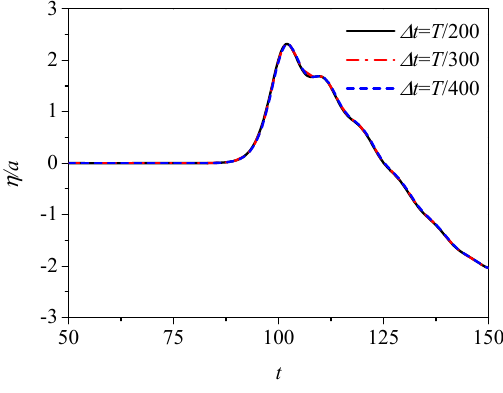
Figure 2. Convergence test for a = 0.05, ω = 0.1.